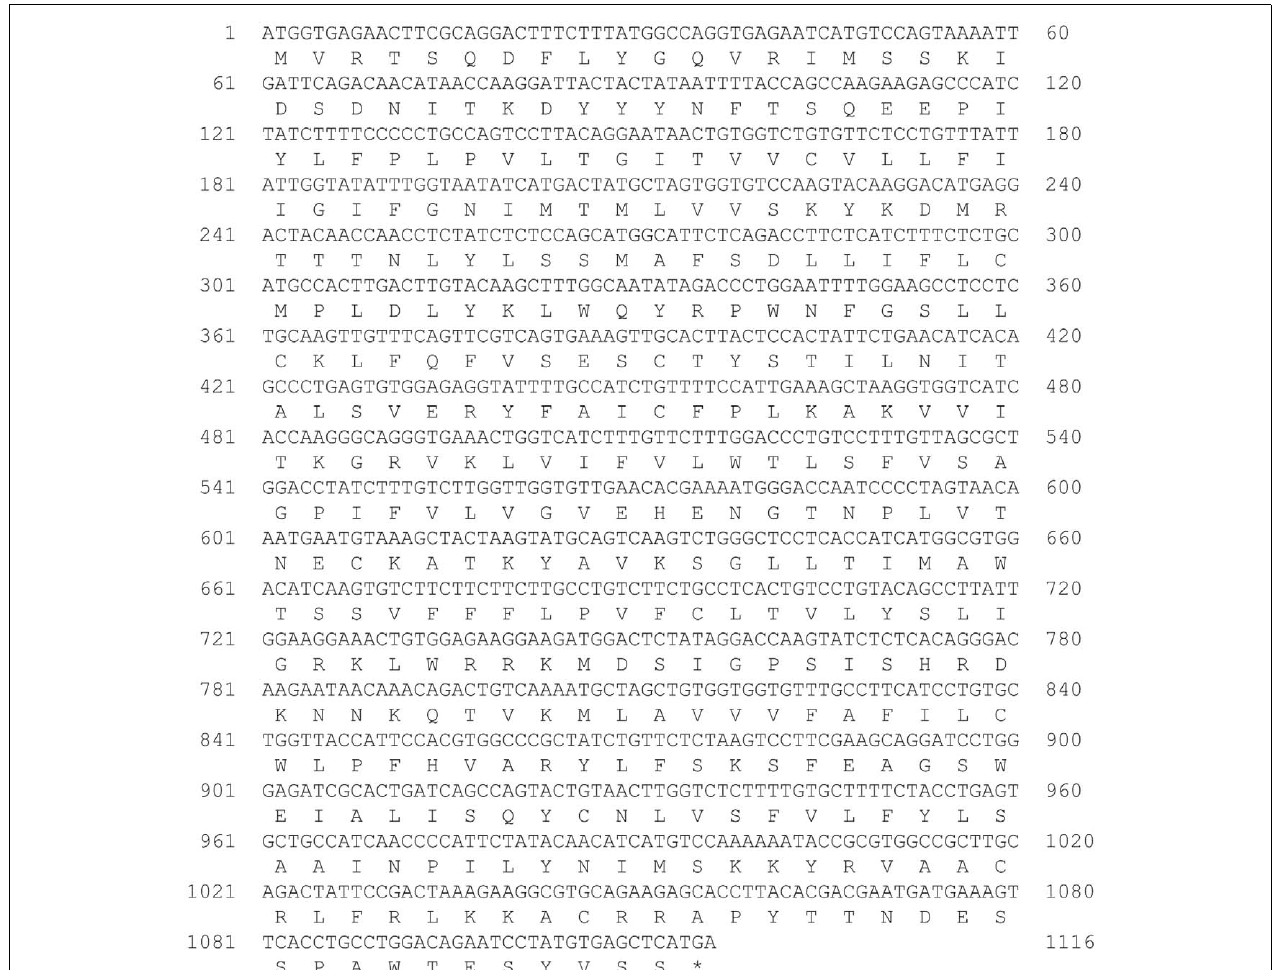
FIGURE 2 | Nucleotide and deduced amino acid sequences of growth hormone secretagogue-receptor (GHS-R) a-like receptor for Japanese tree frog. Asterisk indicates the termination codon (TGA).